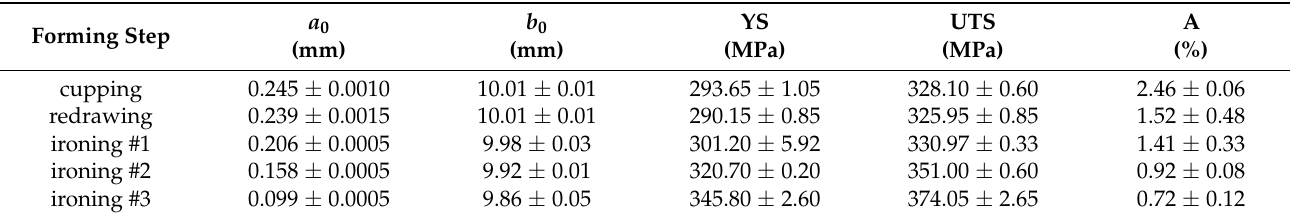
Table 3. Average values and standard deviations of material characteristics measured at different stages of the beverage can forming